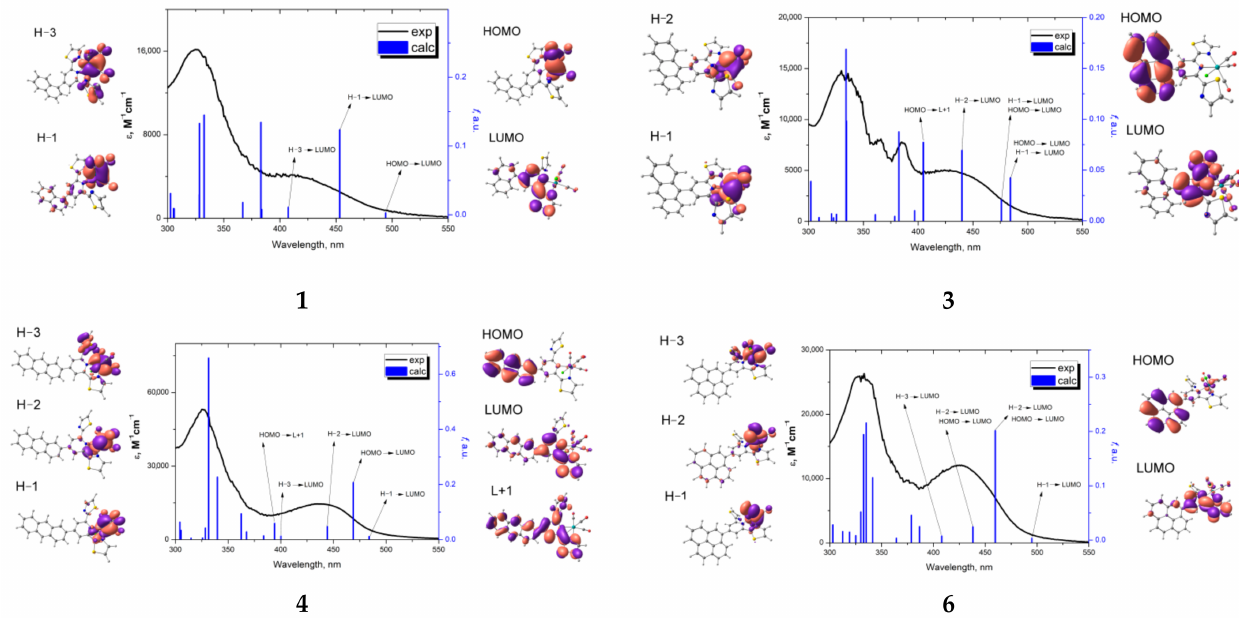
Figure 4. Experimental (black line) absorption spectra of 1 , 3 , 4 , and 6 in CHCl 3 alongside the transitions (blue) computed with TD-DFT/PCM/PBE0/def2-TZVPD/def2-TZVP and molecular orbital plots involved in these